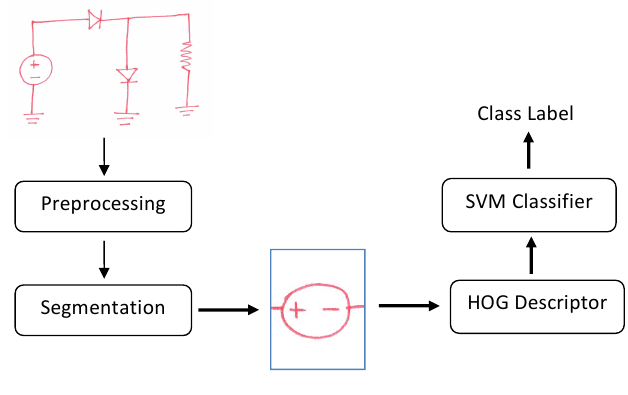
Figure 1. An overview of the proposed system and symbols. Experiments on 20 di ff erent hand-drawn circuits report an F-measure of